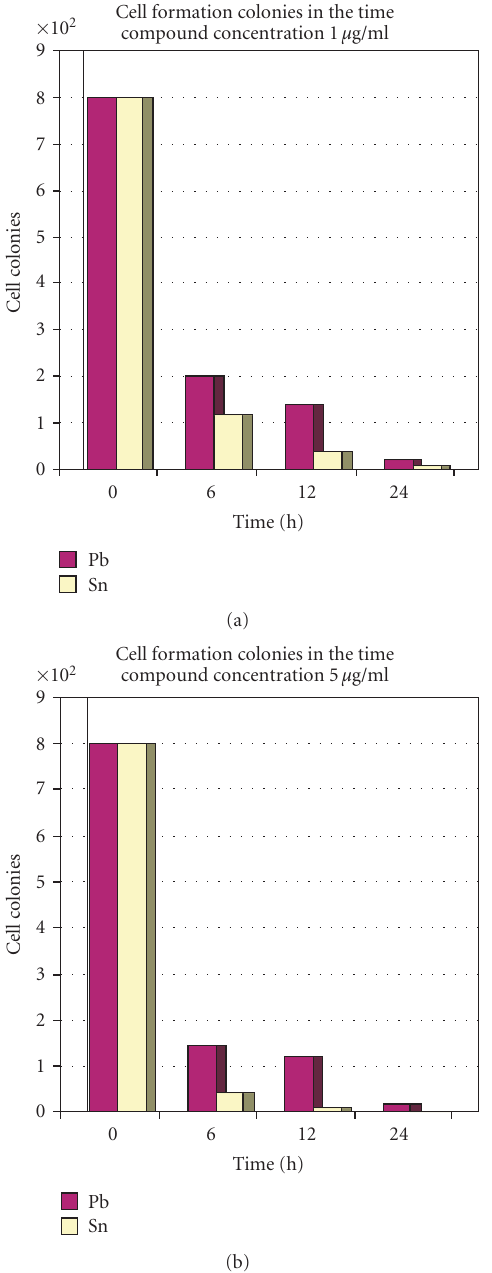
Figure 6: Time dependence of the concentration of cell colonies containing admixtures of (a) 1 μ g/ml TPhT and TPhL; (b) 5 μ g/ml TPhT and